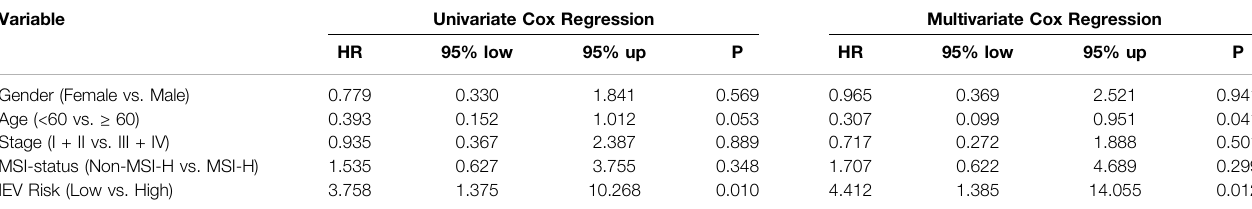
TABLE 2 | Univariate and multivariate Cox regression analysis in the Cancer Genome Atlas-COAD cohort. Variable